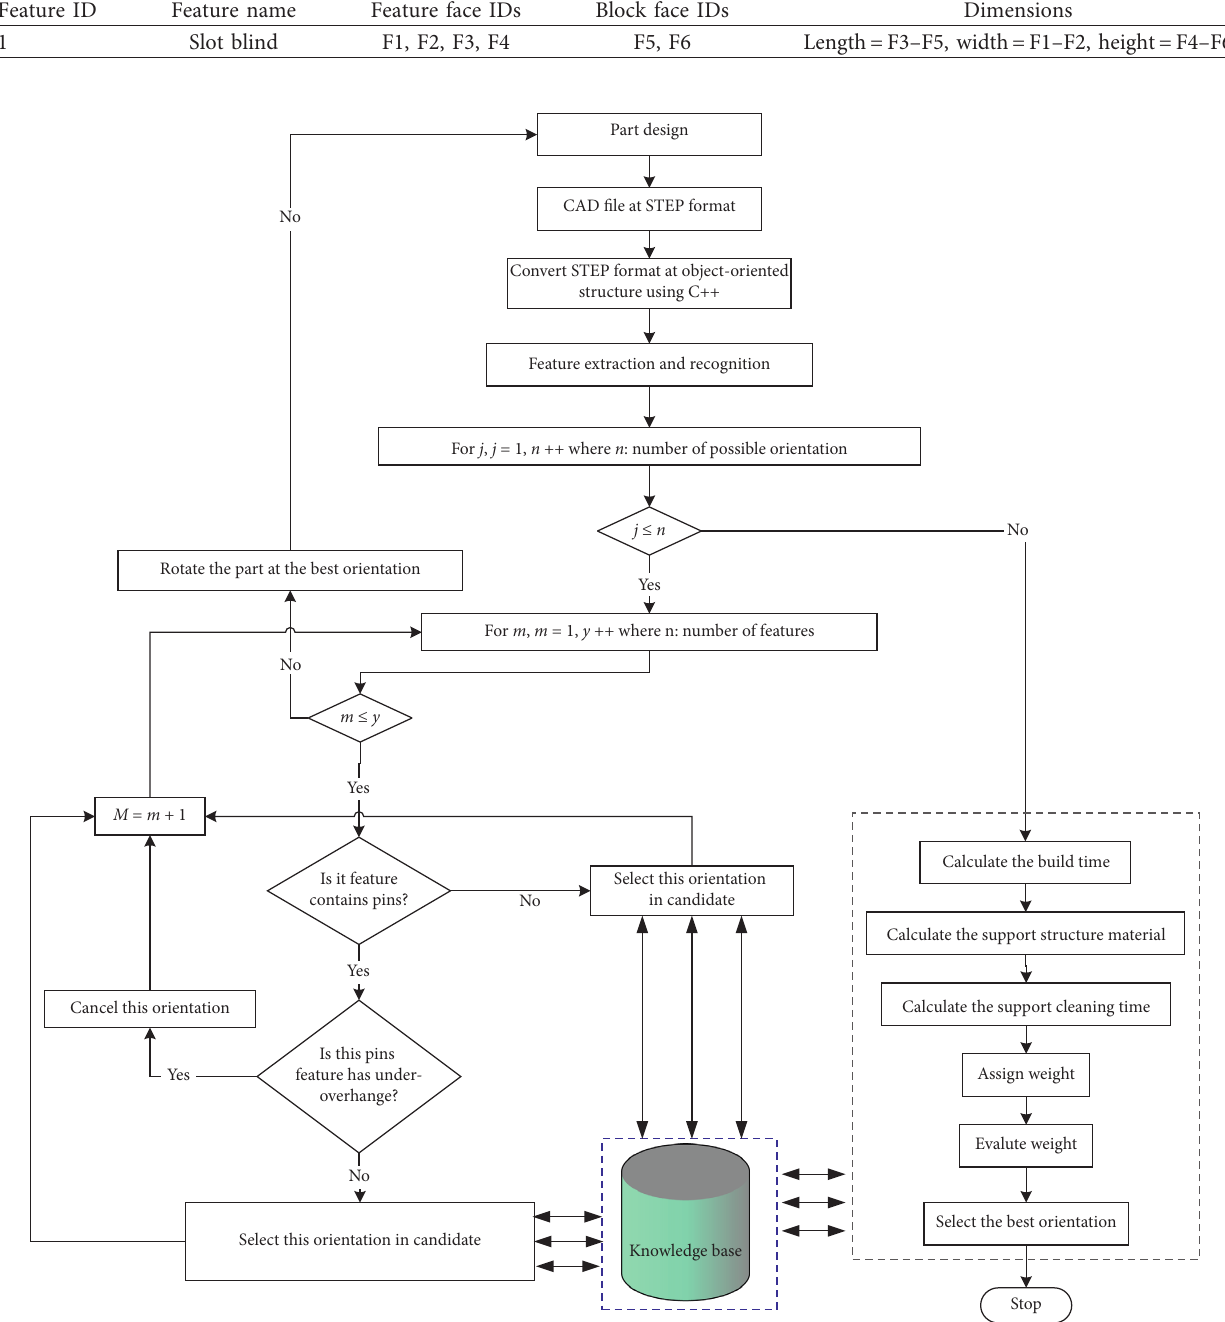
Table 3: Inspection data extracted for the slot blind feature.